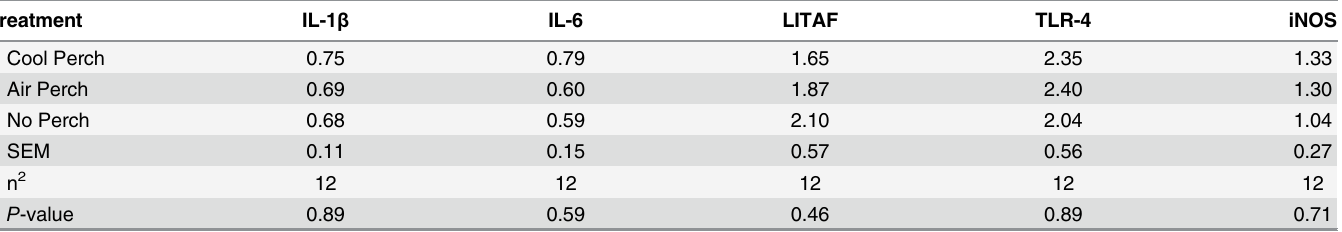
Table 4. The effect of thermally cool perch on mRNA expression of cytokines, toll-like receptors, and inducible nitric oxide synthase in the spleen of 32 week-old laying hens 1 .